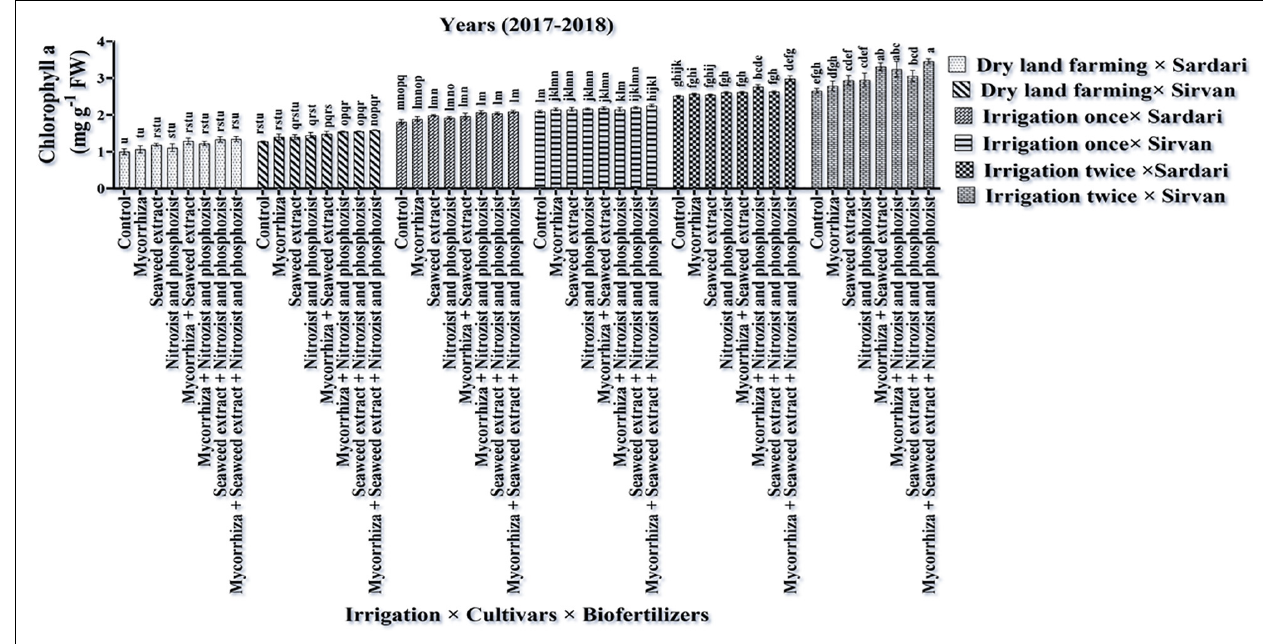
FIGURE 13 | Mean comparisons of triple interaction effect of irrigation × cultivars × biofertilizers on Chlorophyll a content of wheat plant in 2017–2018. Means in each column followed by similar letter(s) are not significantly different at 1% probability level by the LSD